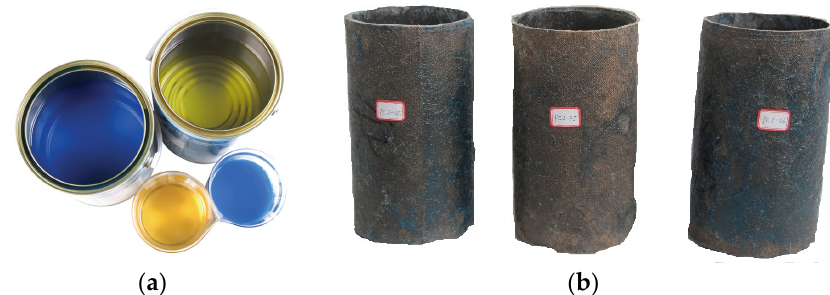
Figure 4. Production of JFRP tubes: ( a ) JN-C3P epoxy, ( b ) prefabricated JFRP tube.